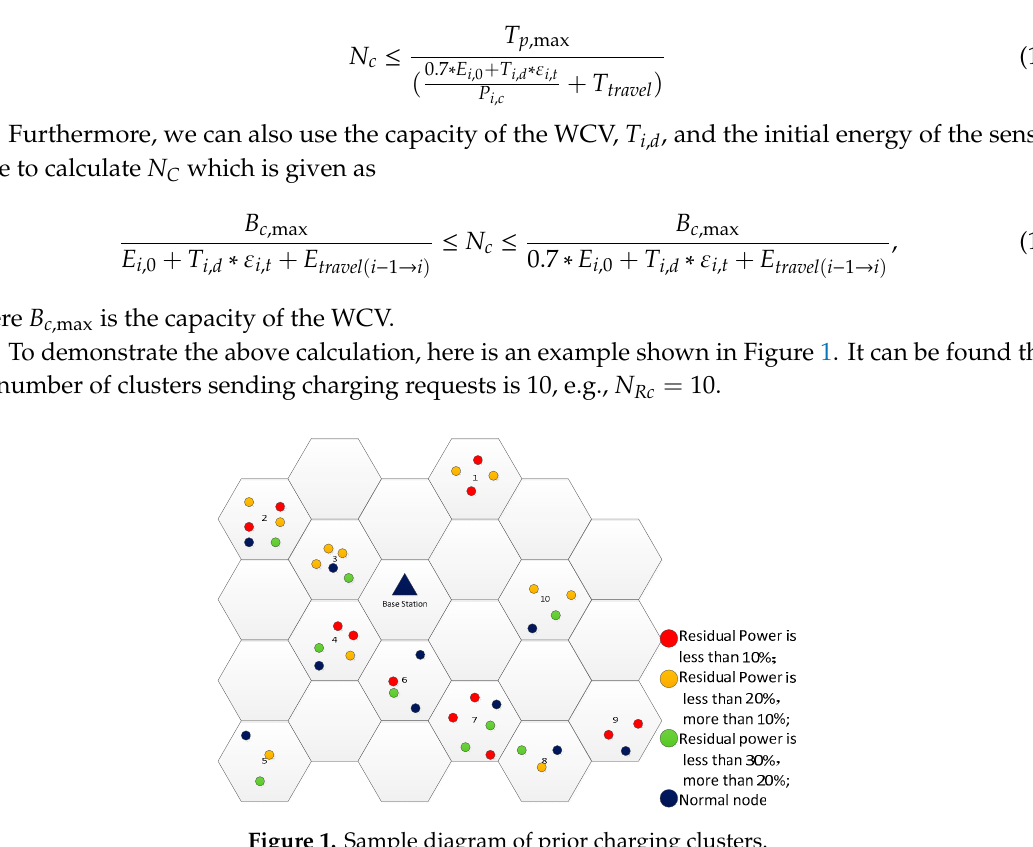
Table 2. The weight value of each cluster. Cluster number